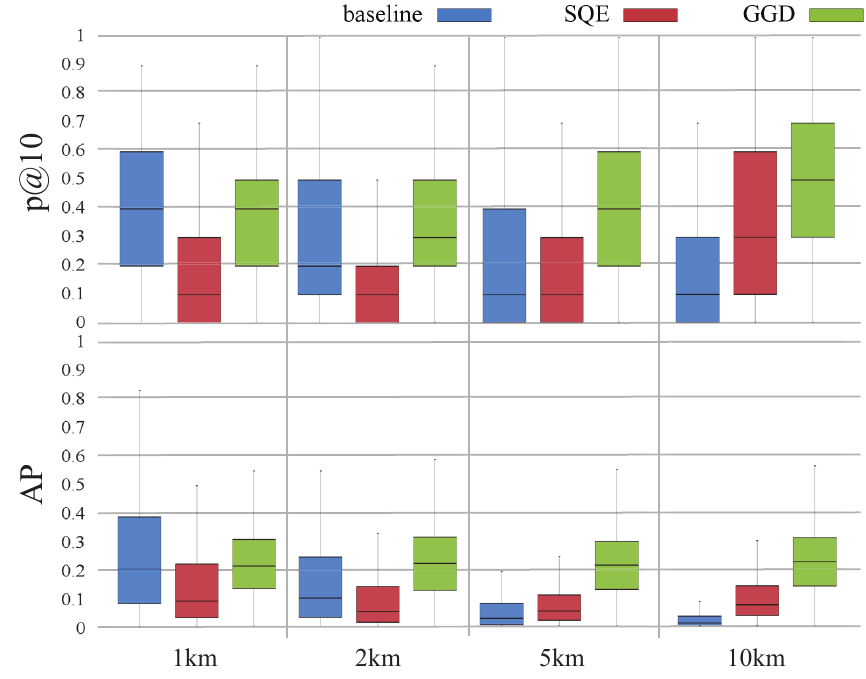
Figure 9: Summary statistics of P@10 and AP for spatial and topical query results combined using Borda for four search radii.